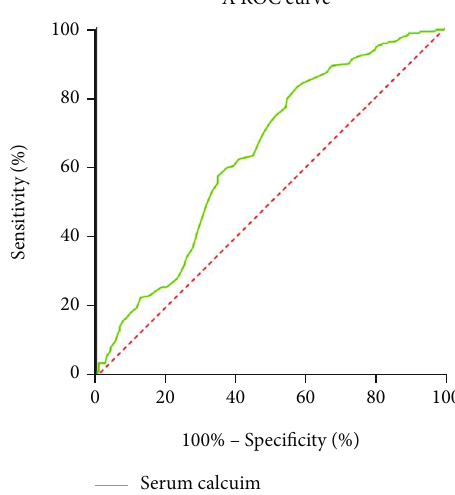
Figure 2: A ROC curve of an independent prognostic protective factor for AP. Note: AP: acute pancreatitis; ROC: receiver operating